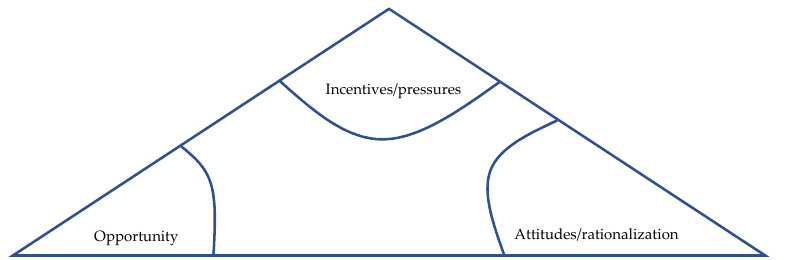
Figure 1. The fraud triangle.